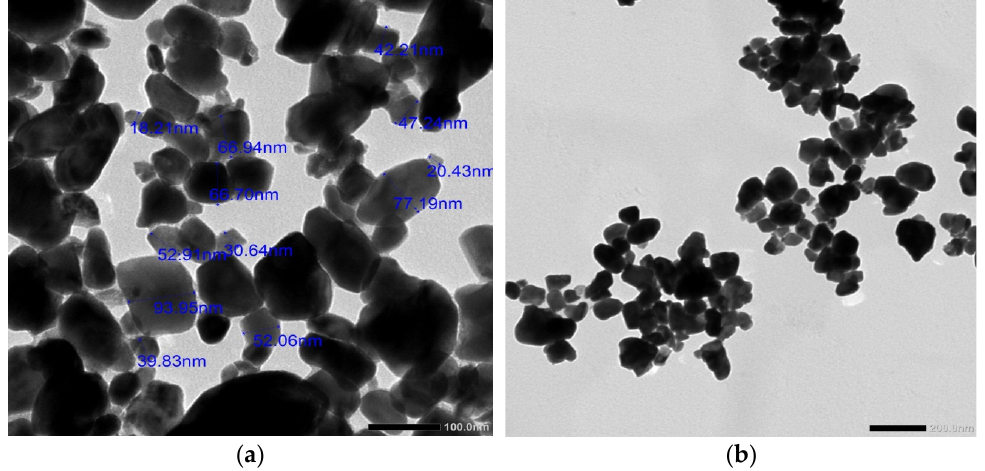
Figure 2. TEM image of WO 3 nanoparticles ( a ) 100 nm scale and ( b ) 200 nm scale. Table 1. Chemical composition, densities, and the codes of the prepared flexible samples.